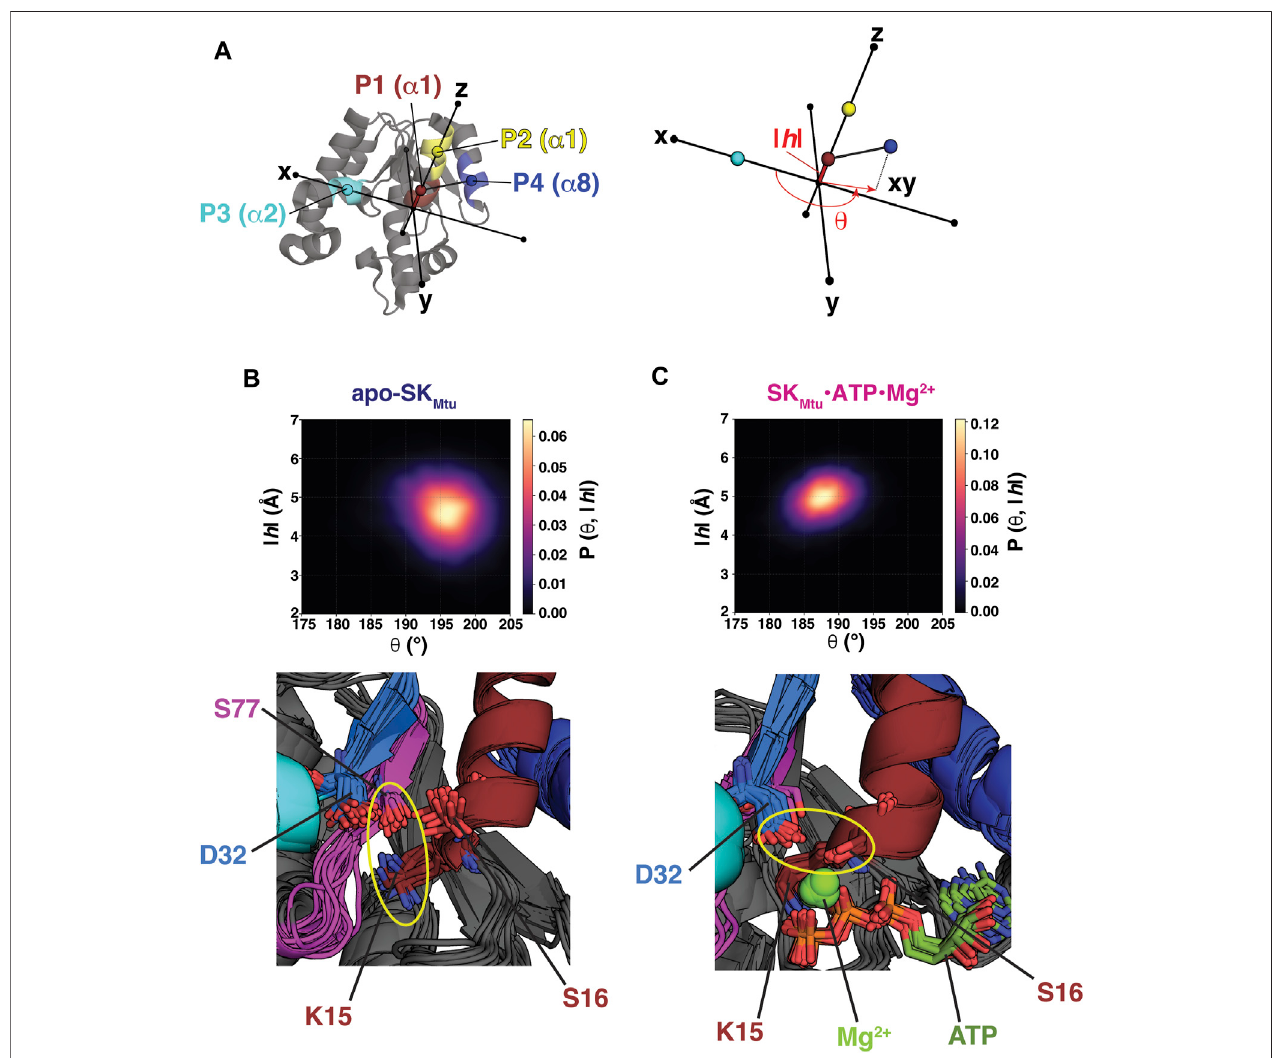
FIGURE 1 | (A) Points P1 (brown), P2 (yellow), P3 (cyan) and P4 (dark blue) used to de fi ne the cylindrical coordinate frame for analyses of the REST2-generated